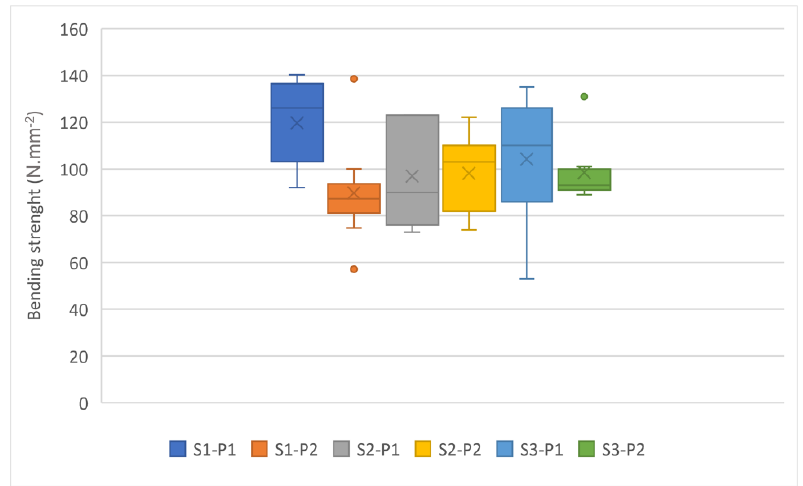
Figure 4. Bending strength at sites 1, 2, 3 and both distances to the pith (P1—10%; P2—90%).